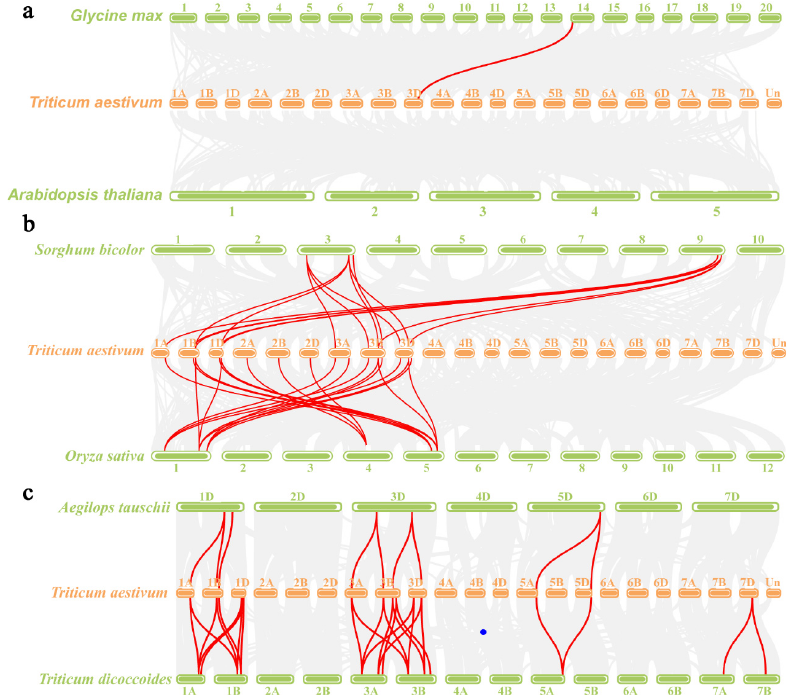
Figure 4. Syntenic relationships of the cystatin genes in bread wheat and six other species. ( a ) Syntenic relationships of cystatins between wheat, Arabidopsis thaliana , and Glycine max . ( b ) Syntenic relationships of cystatins between wheat, Oryza sativa , and S.bicolor. ( c ) Syntenic relationships of cystatins between wheat, Aegilops tauschii , and Triticum dicoccoides. Gray lines in the background represent the synteny blocks of wheat and other plants, while the red lines highlight the syntenic cystatin gene pairs.